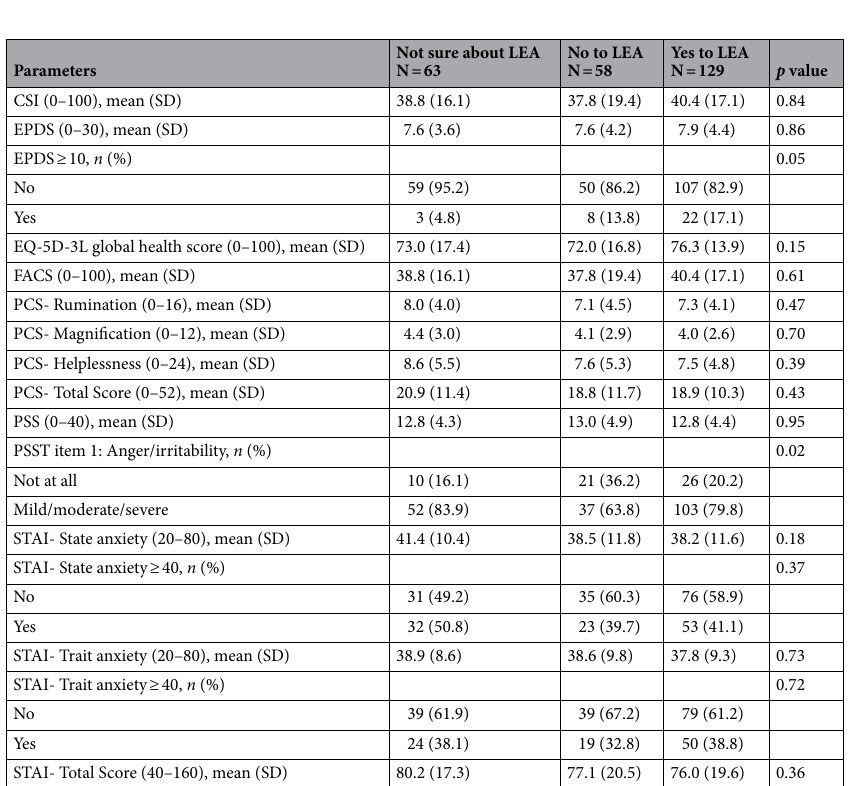
Table 3. Pain and psychological vulnerabilities. The missing data on questionnaires are as follows: CSI (n = 2), EPDS (n = 1), EQ-5D-3L (n = 1), FACS (n = 7), PCS (n = 2), PSS (n = 1), PSST (n = 1), and STAI (n = 1). CI confidence interval, CSI central sensitisation inventory, EPDS Edinburgh postnatal depression scale, EQ-5D-3L EuroQol five-dimensional-three-level, FACS fear-avoidance components scale, LEA labor epidural analgesia, OR odds ratio, PCS pain catastrophizing scale, PSS perceived stress scale, PSST premenstrual symptoms screening tool, STAI state-trait anxiety inventory.